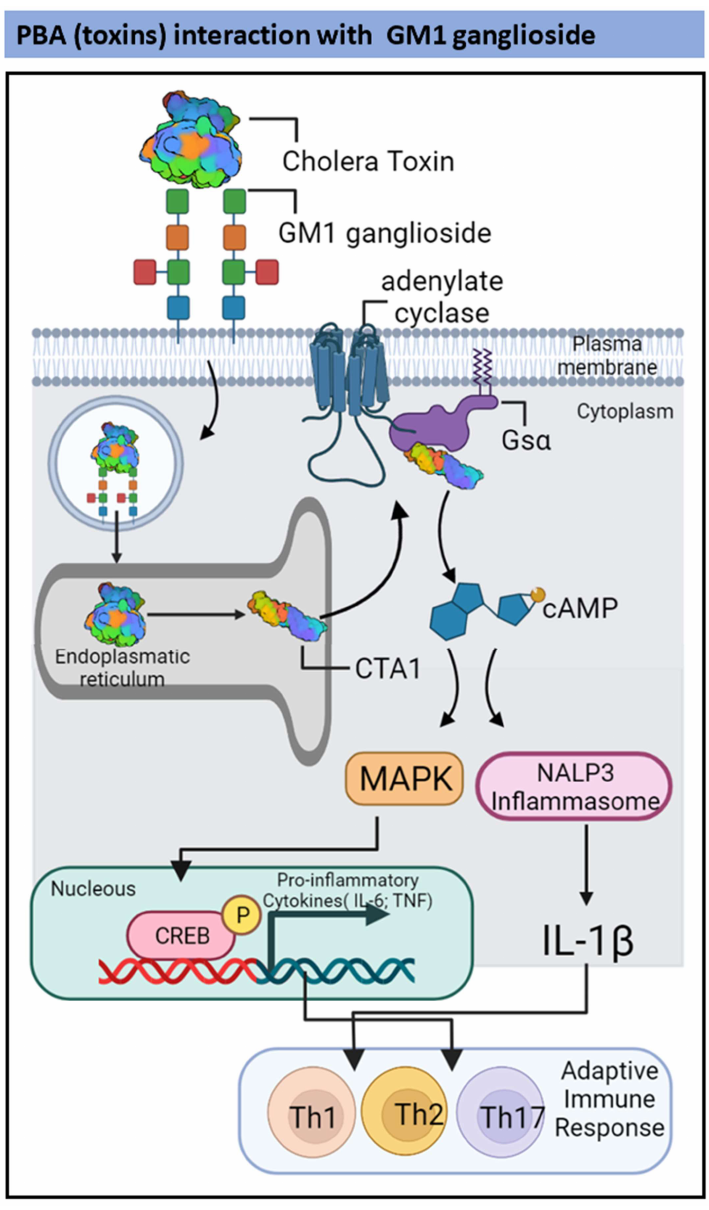
Figure 2. Molecular targets of protein toxins and the adaptive immune response associated with the ganglioside GM1. Cholera toxin (CT) can bind with the ganglioside GM1 on the cell surface of APC through CT subunit B (CTB) and be internalized into the endoplasmic reticulum (ER). Within the ER, a disulfide bridge of in the CTB-CTA2 complex is reduced, releasing the CTA1 chain. This chain is then translocated to the cytosol, where it binds to Gs α , which activates adenylate cyclase (AC) to produce intracellular cAMP, MAPKs and the NALP3 inflammasome. As a mucosal adjuvant, CT stimulates innate immune cells to induce Th1-, Th2-, and Th17-cell adaptive immune responses, including antibody (Ab) production and T-cell responses systemically and specifically in mucosal